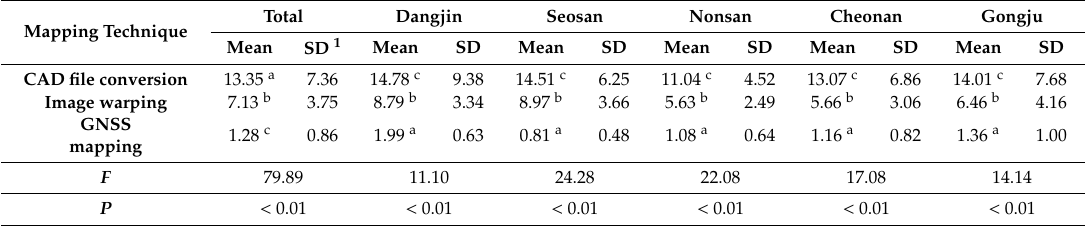
Table 3. Comparison of point-correspondence results (RMSE) by mapping